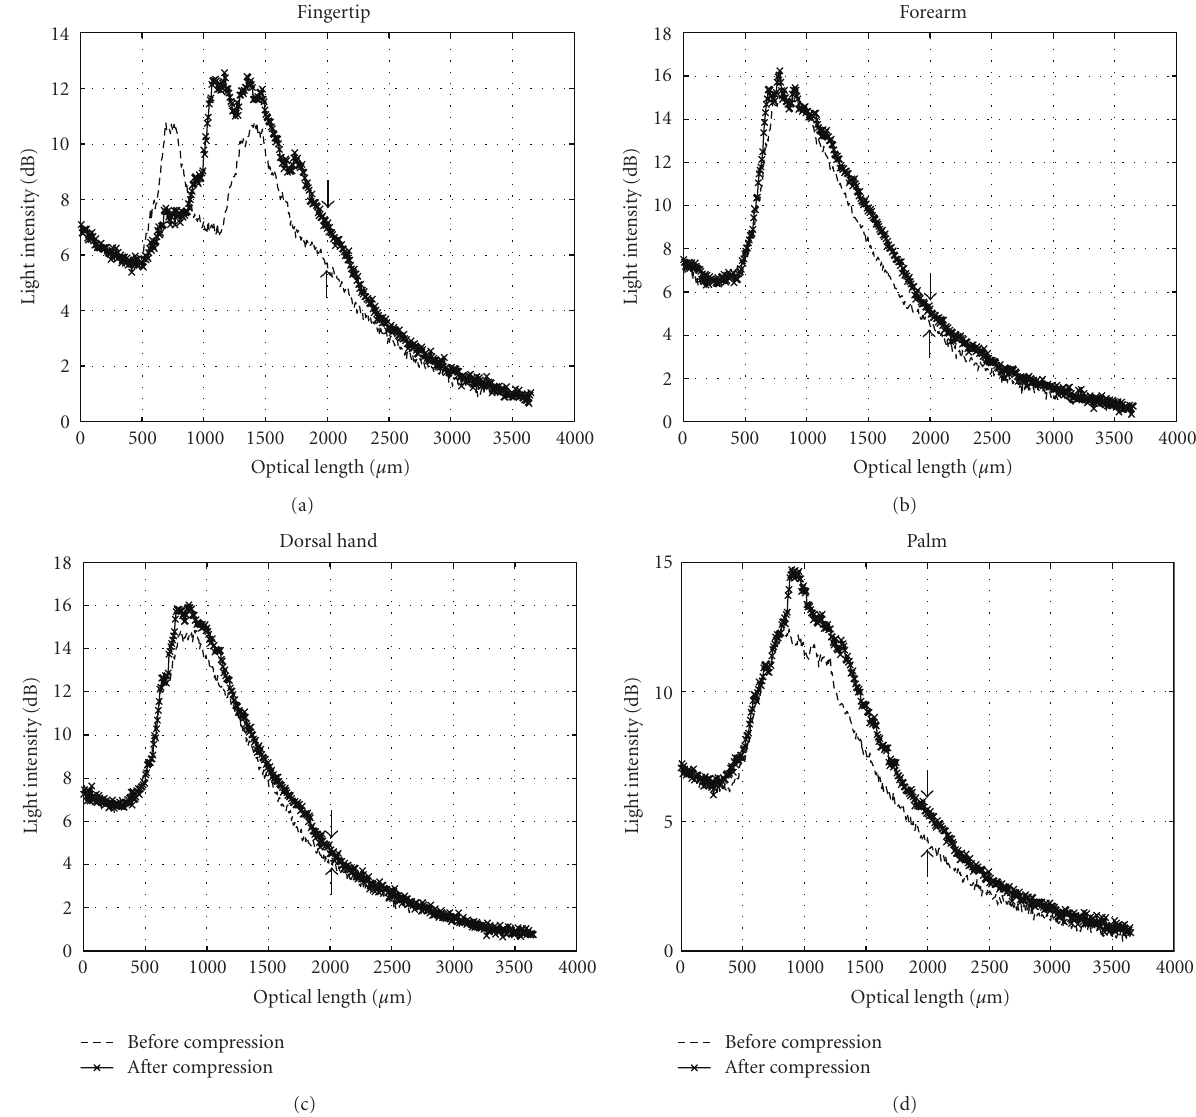
Figure 6: Average A-scan profiles for each of the anatomical regions studied for one representative volunteer before and after compression. Arrows denote increased signal intensity at 1 mm physical depth in